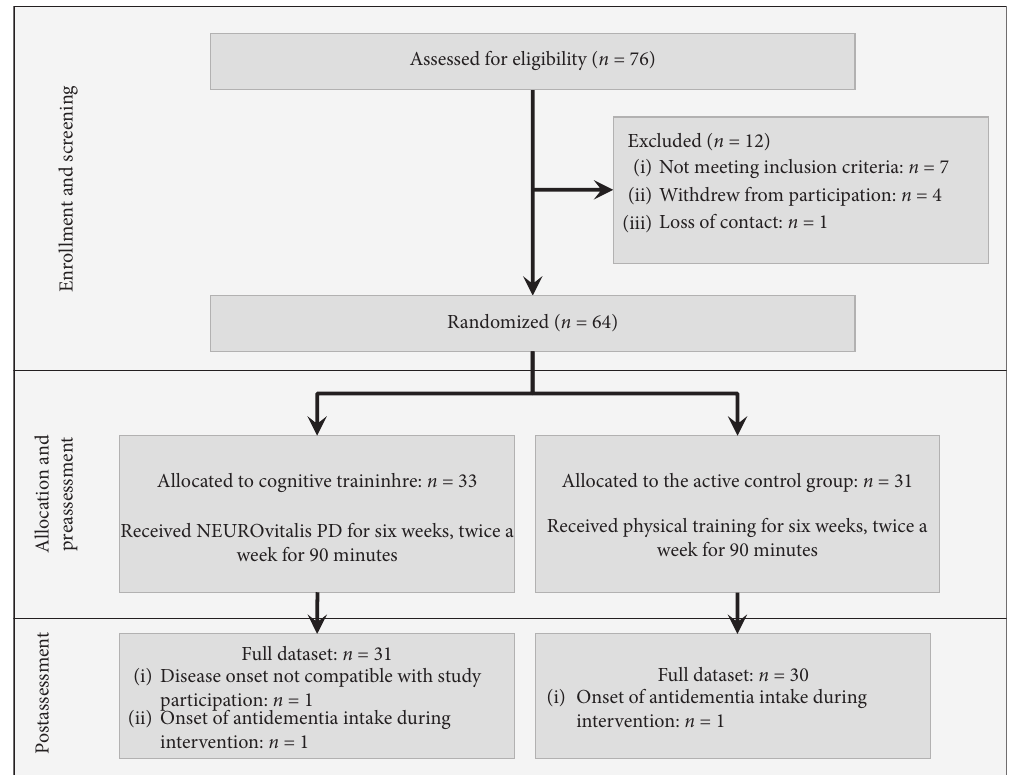
Figure 1: Participation